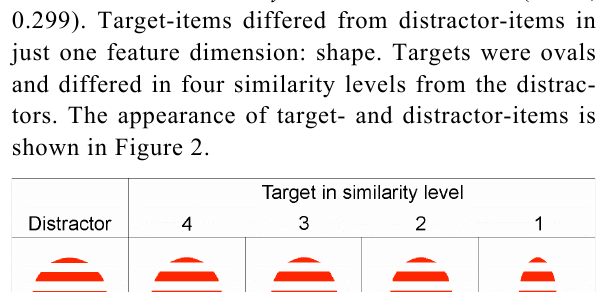
Four, six or eight items were adjacently located at twelve equispaced positions on an imaginary circle with a diameter of 8° visual angle (see Figure 3A).